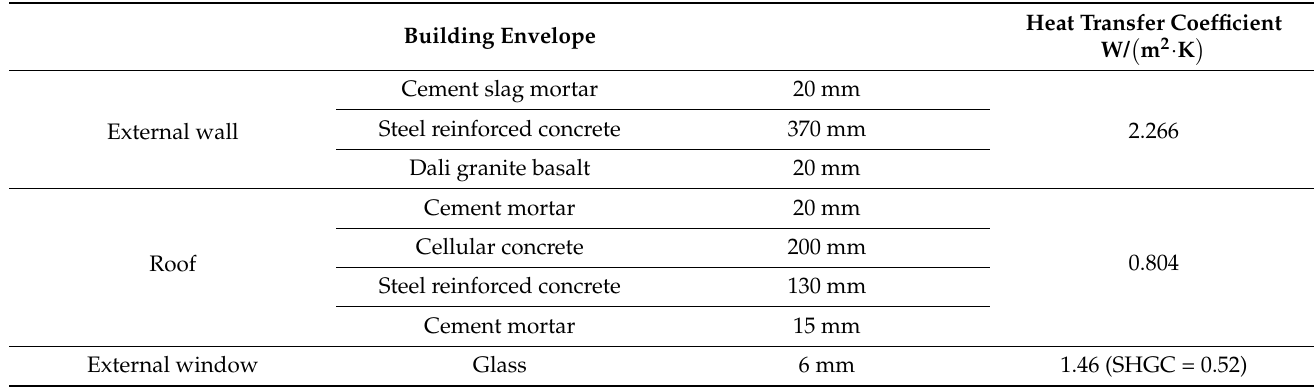
Figure 7. Schematic diagram of the TRNSYS simulation system.